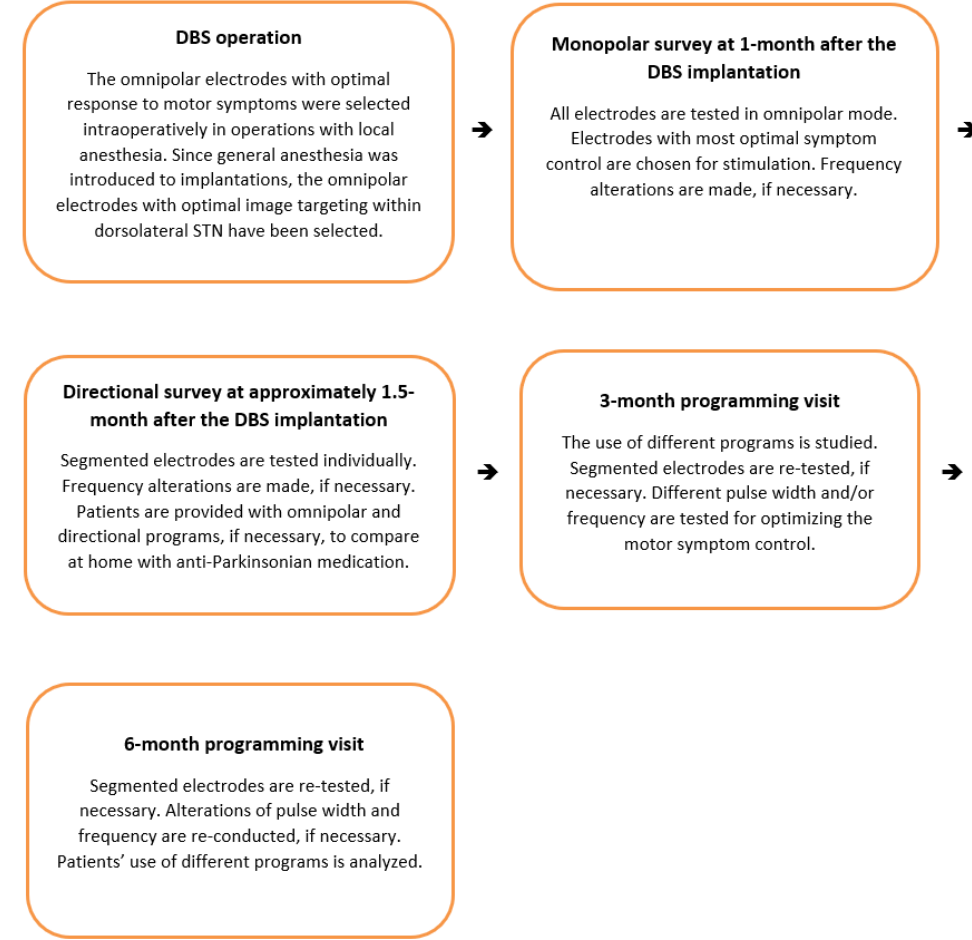
Figure 1. In-hospital deep brain stimulation (DBS) programming protocol.